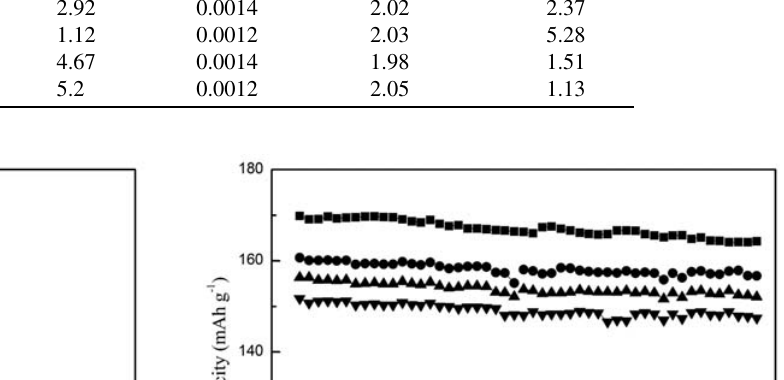
Table 2. Different concentration of TPU/PVDF/PS membranes’parameters and ionic conductivity